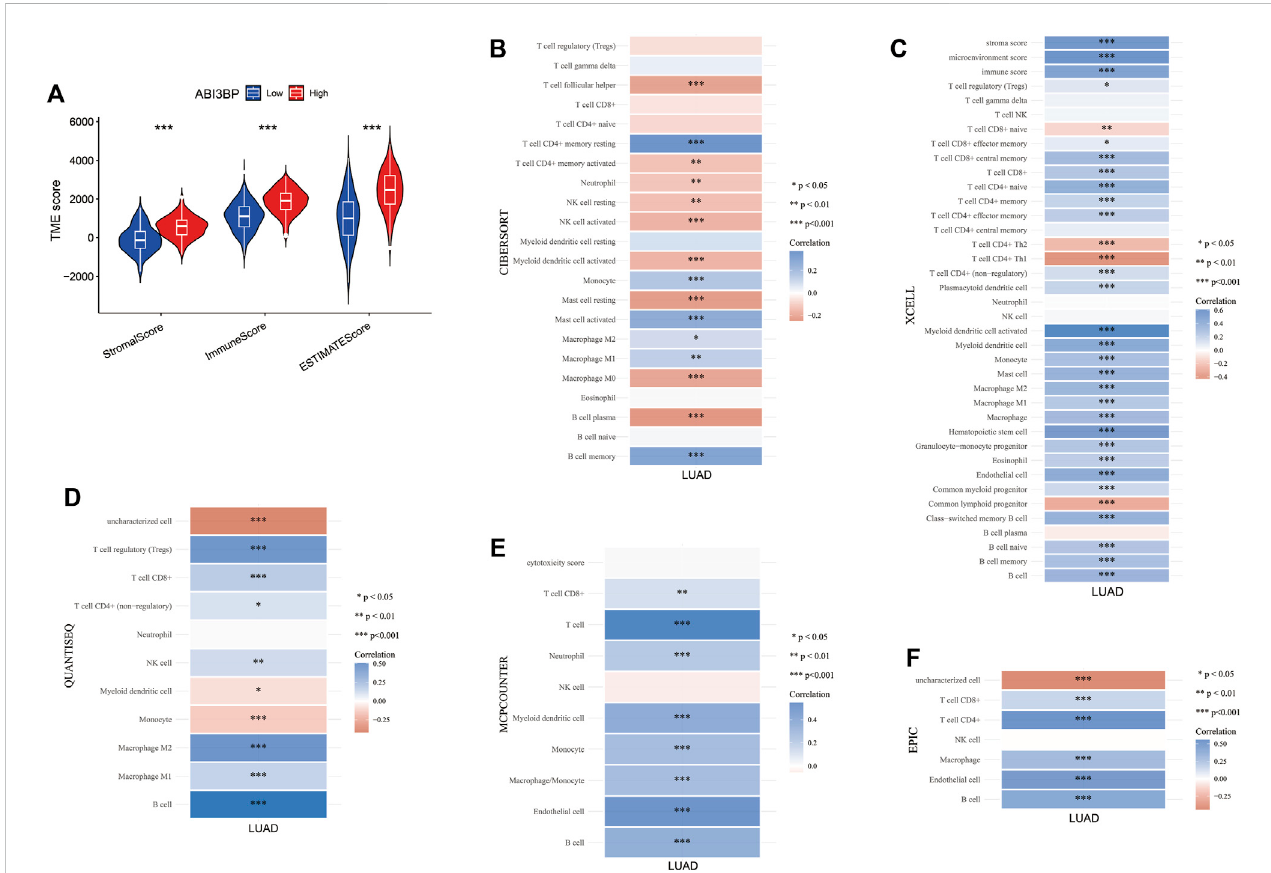
FIGURE 7 RelationshipbetweenABI3BPandimmunoin fi ltrationinLUAD. (A) TMEscoreofABI3BP.CIBERSORT (B) ,XCELL (C) ,QUANTISEQ (D) ,MCPCOUNTER (E) , and EPIC (F) analysis between ABI3BP and tumor immune cells in